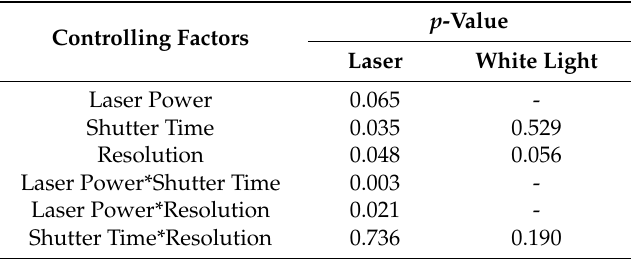
Table 5. p -Values using ANOVA for the laser-based and white light handheld scanners (scanning time).